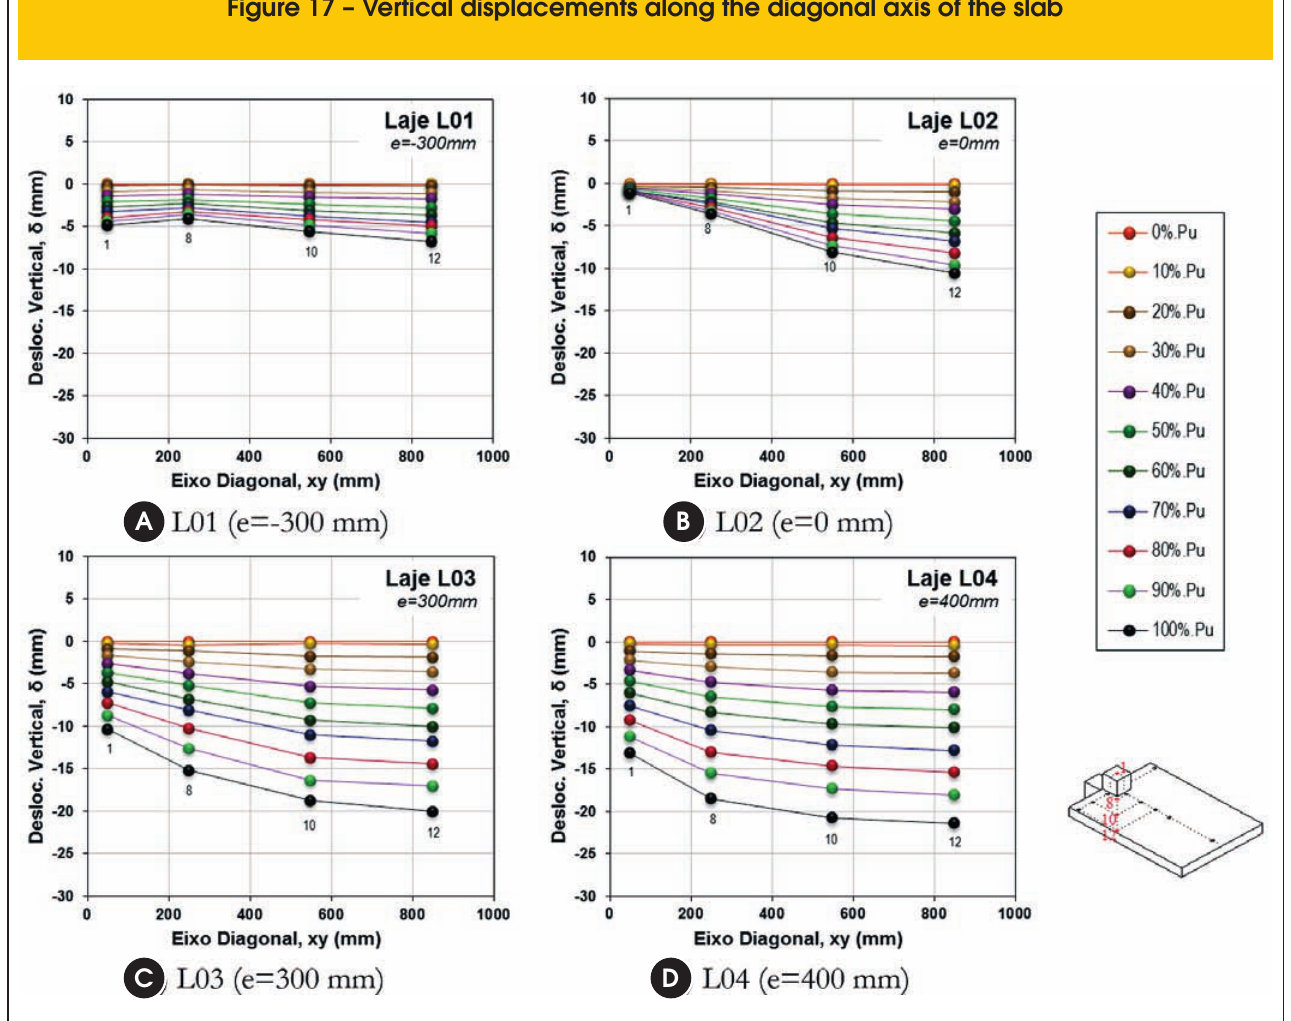
Figure 17 – Vertical displacements along the diagonal axis of the